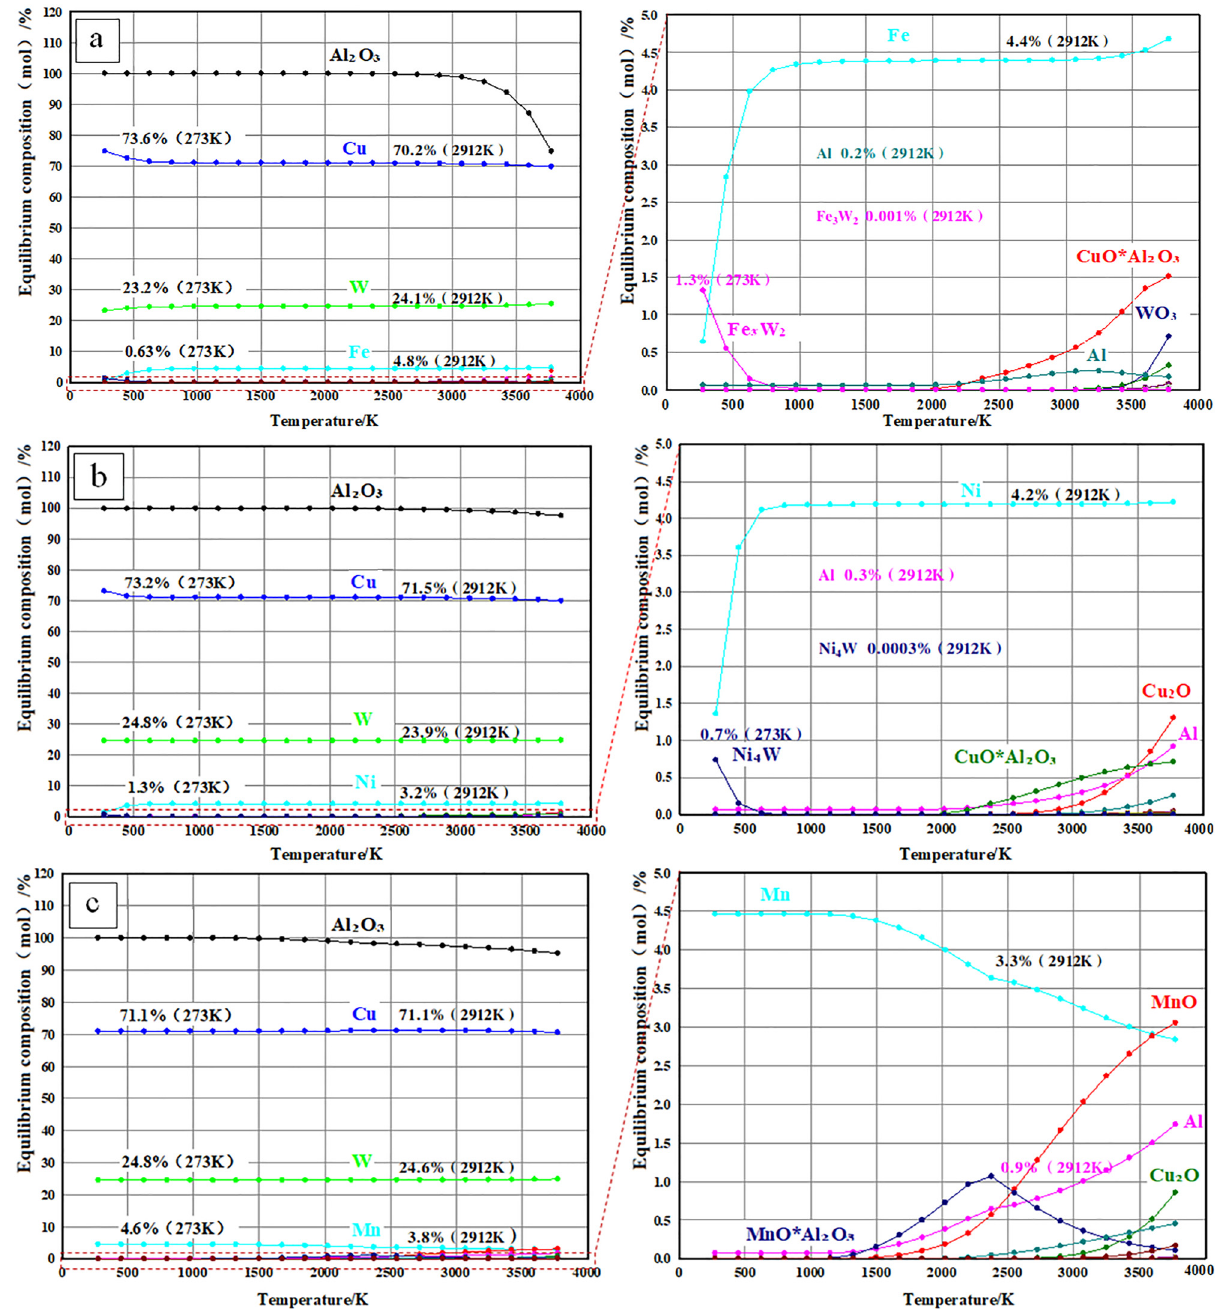
Figure 1: Thermodynamic equilibria of ( a ) Al – CuO – WO 3 – Fe 2 O 3 , ( b ) Al – CuO – WO 3 – NiO, and ( c ) Al – CuO – WO 3 – MnO 2